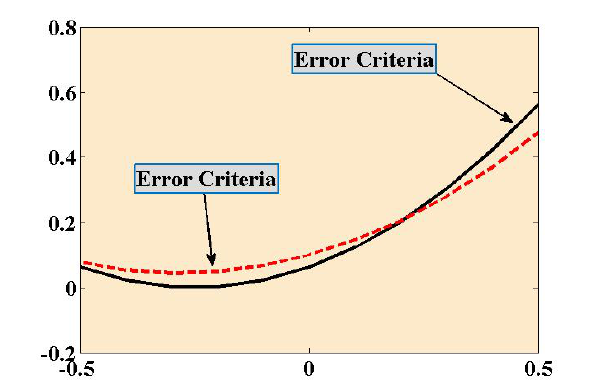
Figure 5. Error level between the original (black line) and proposed (dotted line)